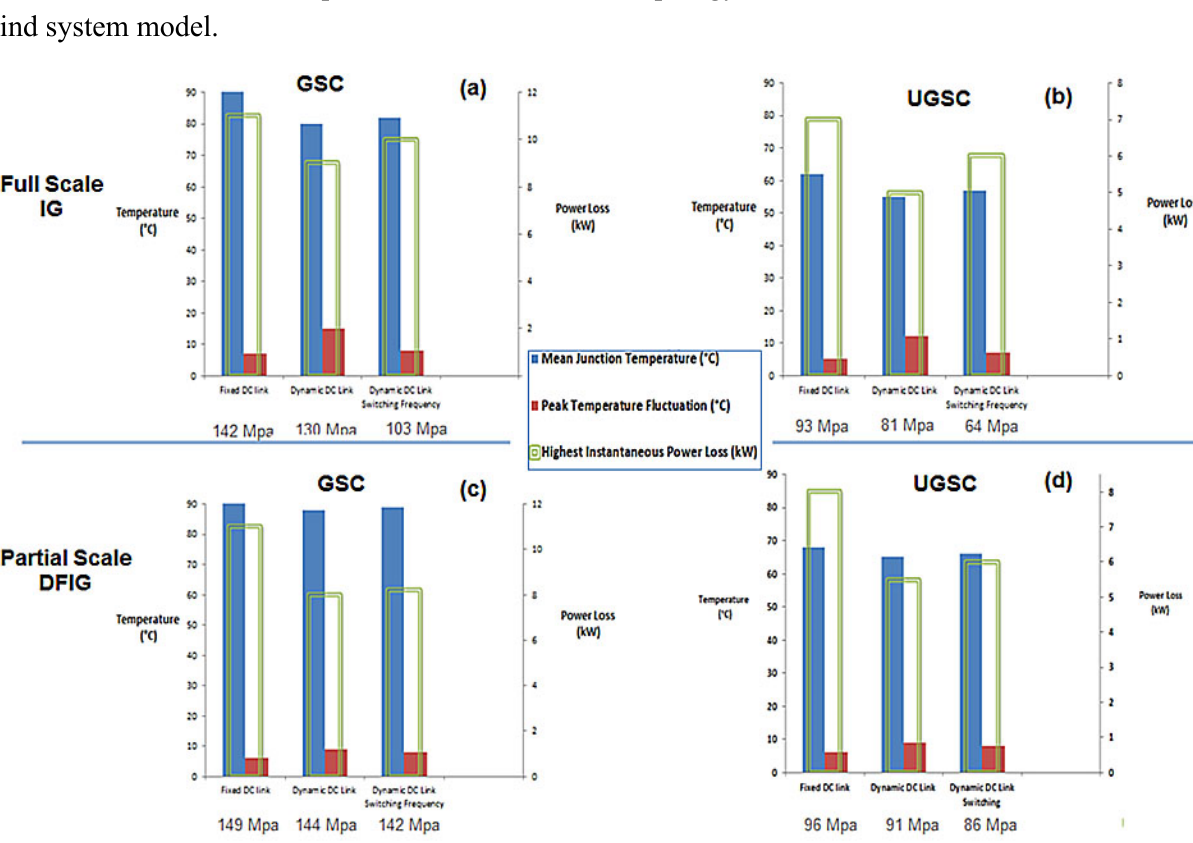
Figure 16. Overall thermo-mechanical and electro-thermal for ( a , c ) generator and ( b , d ) grid side power modules on FS and on PS doubly fed induction generator (DFIG) based BTB